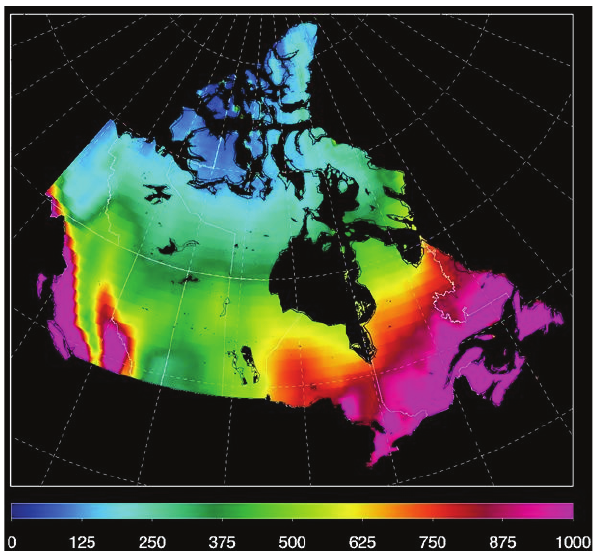
Fig. 8. Spatial distribution of mean annual precipitation (mmyr − 1 ) over Canada’s landmass during the 30yr of